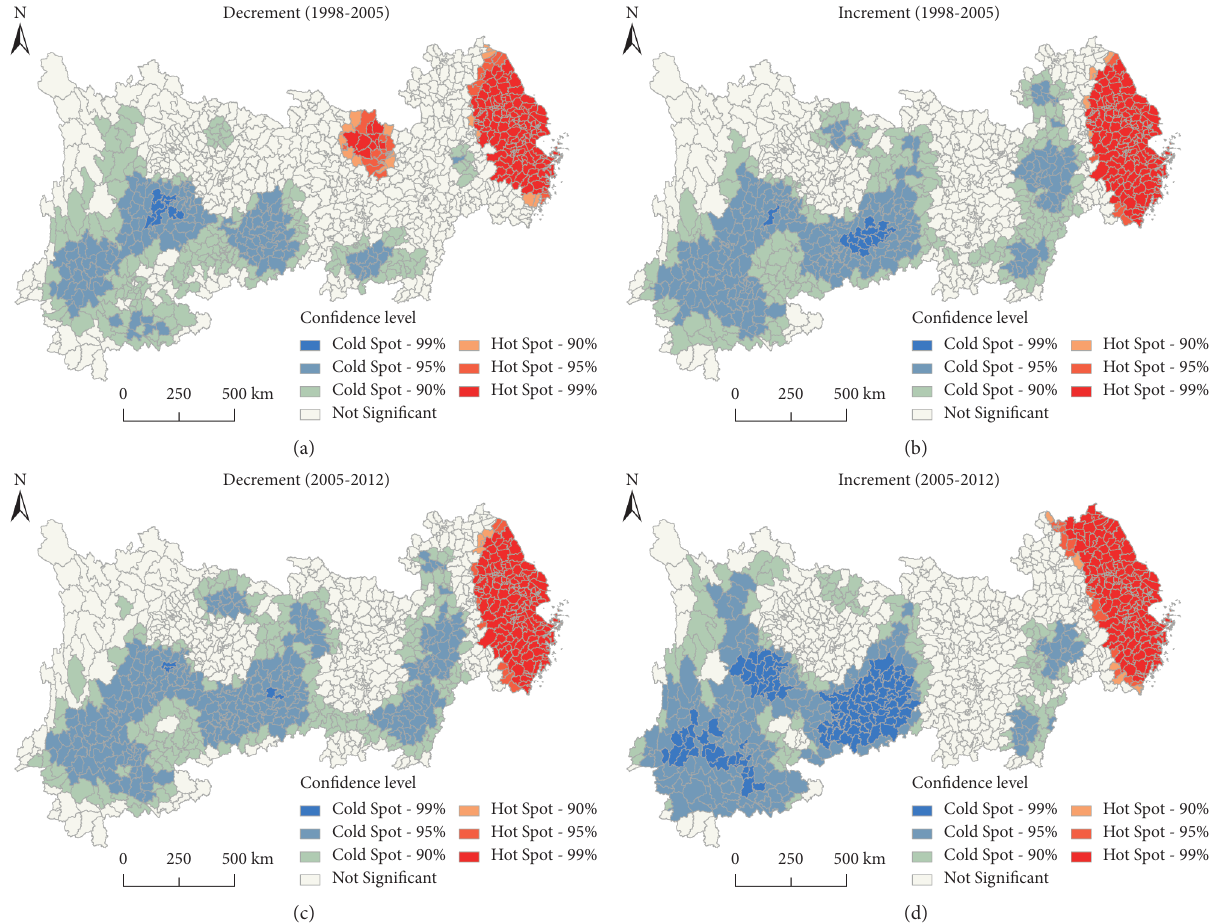
Figure 8: Hot spot analysis of changes in the number of water pollution-intensive enterprises in the Yangtze River Economic Belt. (a) Decrement (1998–2005). (b) Increment (1998–2005). (c) Decrement (2005–2012). (d) Increment